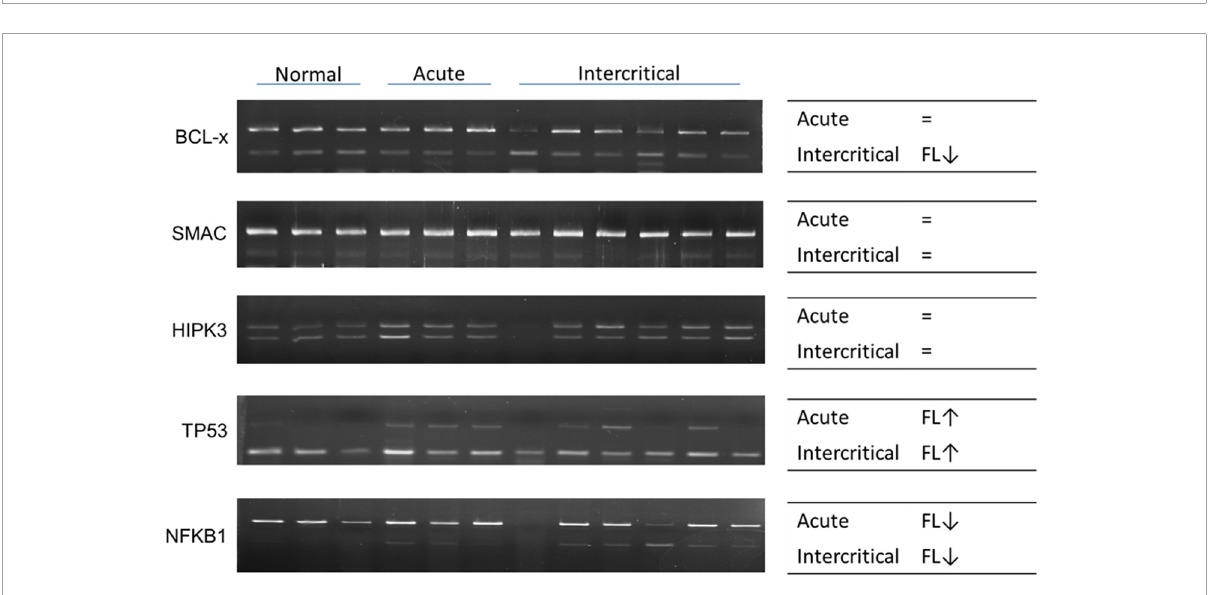
FIGURE11 RNA alternative splicing changed in patients with gout. Alternative splicing of BCL-x , SMAC , HIPK3 , TP53 , and NFKB1 were detected in nine patients with gout, including three patients with acute gout, and six with intercritical gout. Three normal samples were used as the control. Right panels indicate the trend of alternative splicing changes in patients with gout; FL represents full-length; arrow represents increase or decrease; and the sign of equality represents no significant change. The PCR product sizes of BCL-x were 318 and 129 bp, those of SMAC were 250 and 118 bp, those of HIPK3 were 244 and 181 bp, those of TP53 were 201 and 92 bp, and those of NFKB1 were 346 and 187